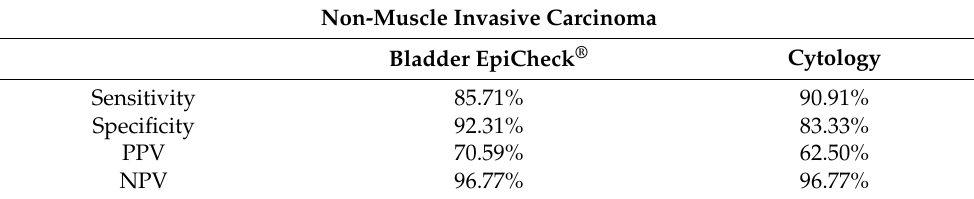
Table 3. Sensitivity, specificity, positive predictive value, and negative predictive value of bladder EpiCheck ® and cytology in high-grade urothelial